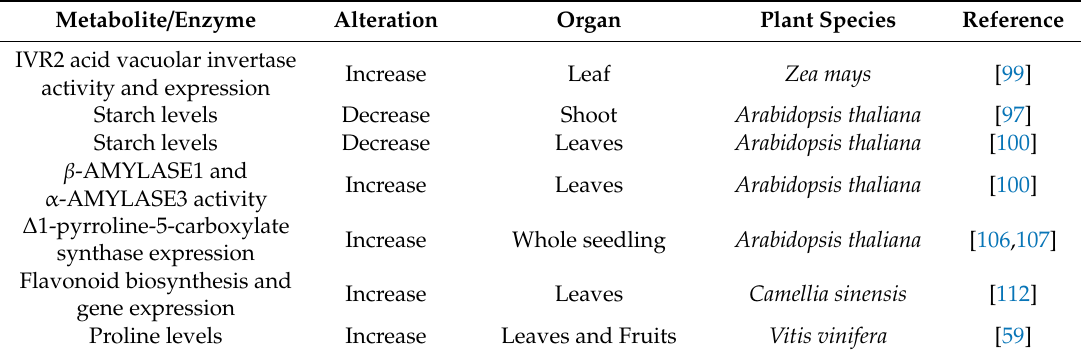
Table 1. Representative metabolites and enzymes associated with primary and secondary metabolisms that are a ff ected by